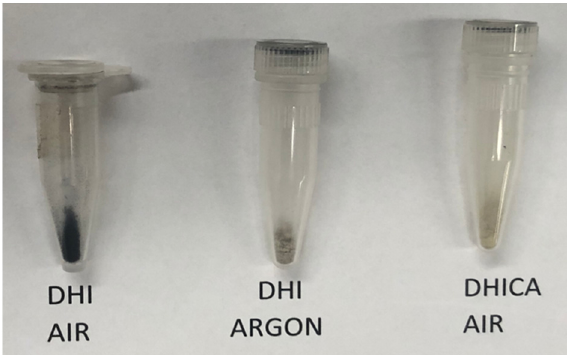
Figure 3. Stability of DHI stored at room temperature for seven days in solid state. Int. J. Mol. Sci. 2020 , 21 , x FOR PEER REVIEW